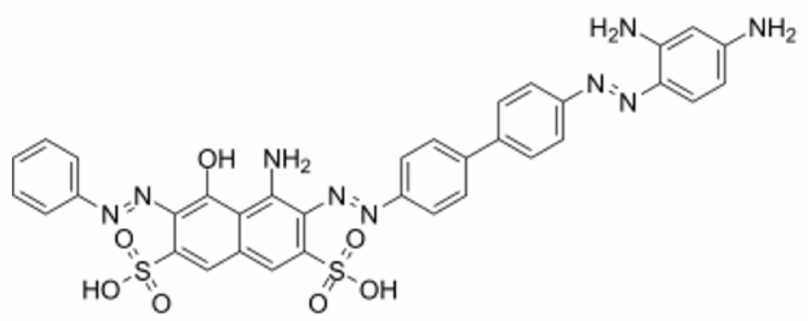
Figure 1. The structure of ferristatin II molecule (adopted from https://www.chemsrc.com/en/cas/ 22244-14-0_1559138.html, accessed on 31 December